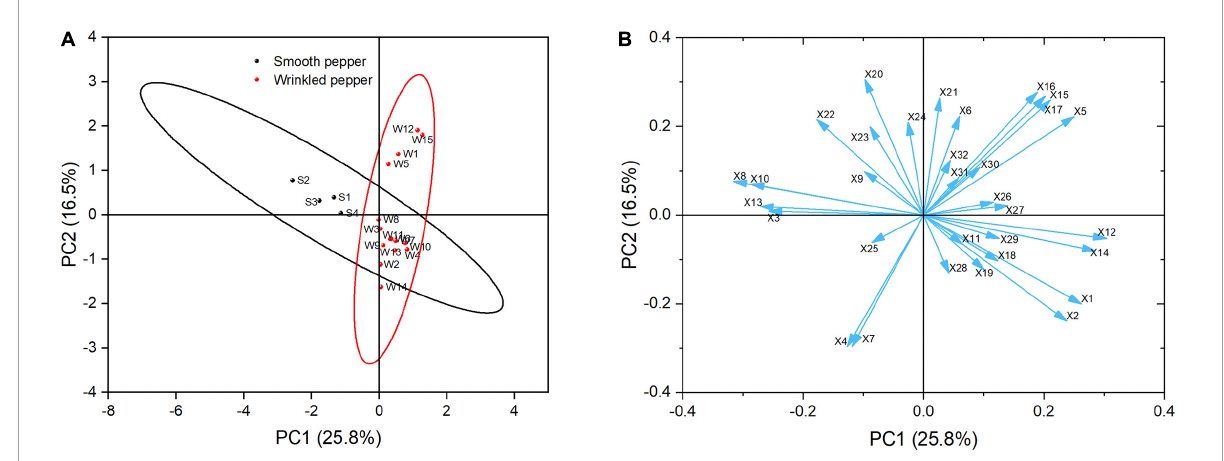
FIGURE8 The PCA of pepper samples with different score (A) and loading (B) plot. Circles in panel (A) represent 95% Confidence Ellipse. The arrow in panel (B) indicates the loadings. X1: Texture score, X2: Moisture content, X3: Maximum penetrating force, X4: Maximum shearing force, X5: Fruit shape index, X6: Specific gravity, X7: Pericarp thickness, X8: Cuticle thickness, X9: Cellulose content, X10: Lignin, X11: Protopectin, X12: a* value, X13: b* value, X14: L* value, X15: Capsaicin, X16: Dihydrocapsaicin, X17: Pungency, X18: Vitamin C, X19: Soluble sugar, X20: Malic acid, X21: Citric acid, X22: Oxalic acid, X23: Fumaric acid, X24: α -ketoglutarate, X25: Alcohol, X26: Aldehyde, X27: Ester, X28: Ketone, X29: Alkene, X30: Alkane, X31: VOC Acid, X32: Other